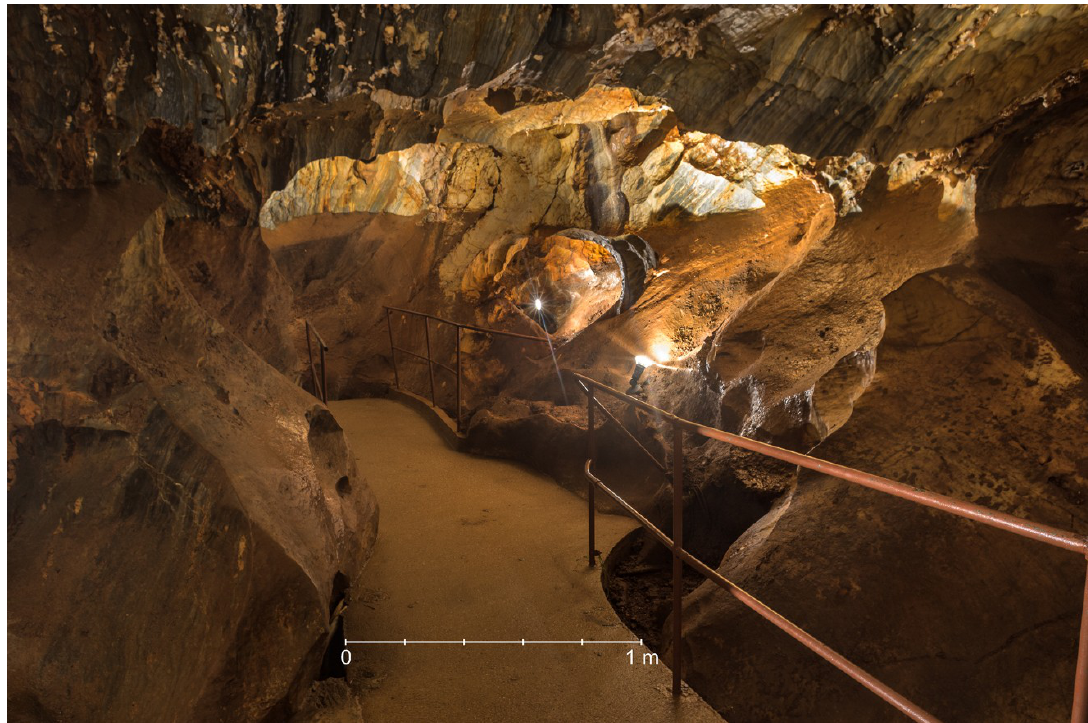
Figure 1. Location of the Ochtiná Aragonite Cave.